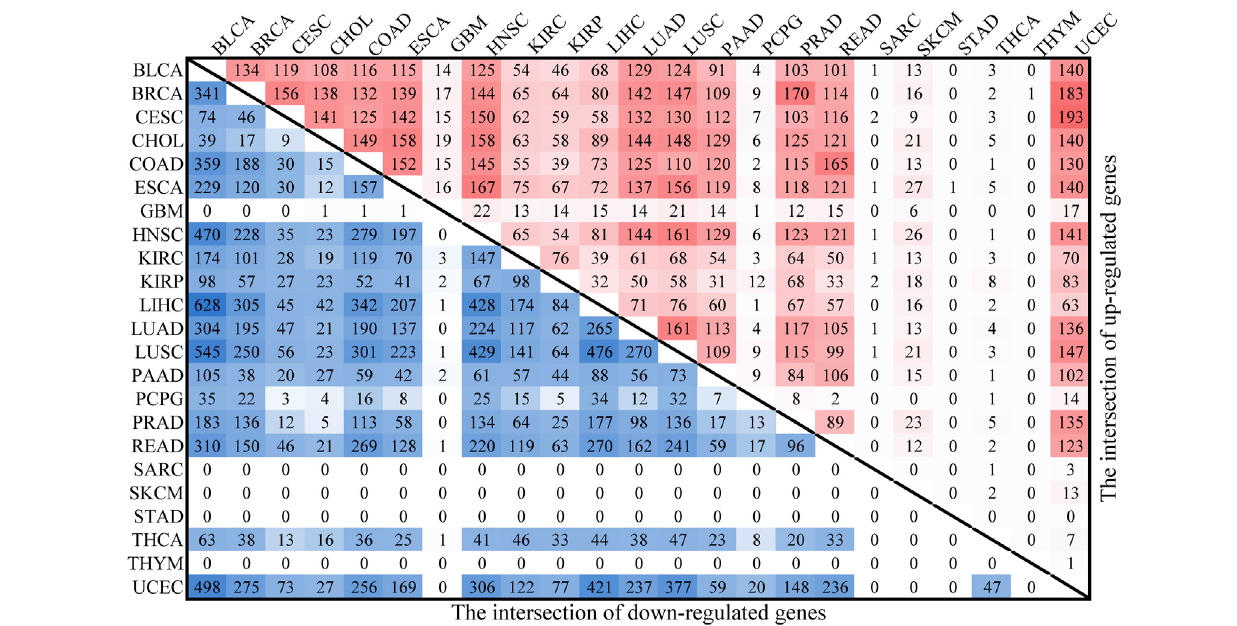
Frontiers in Cell and Developmental Biology |